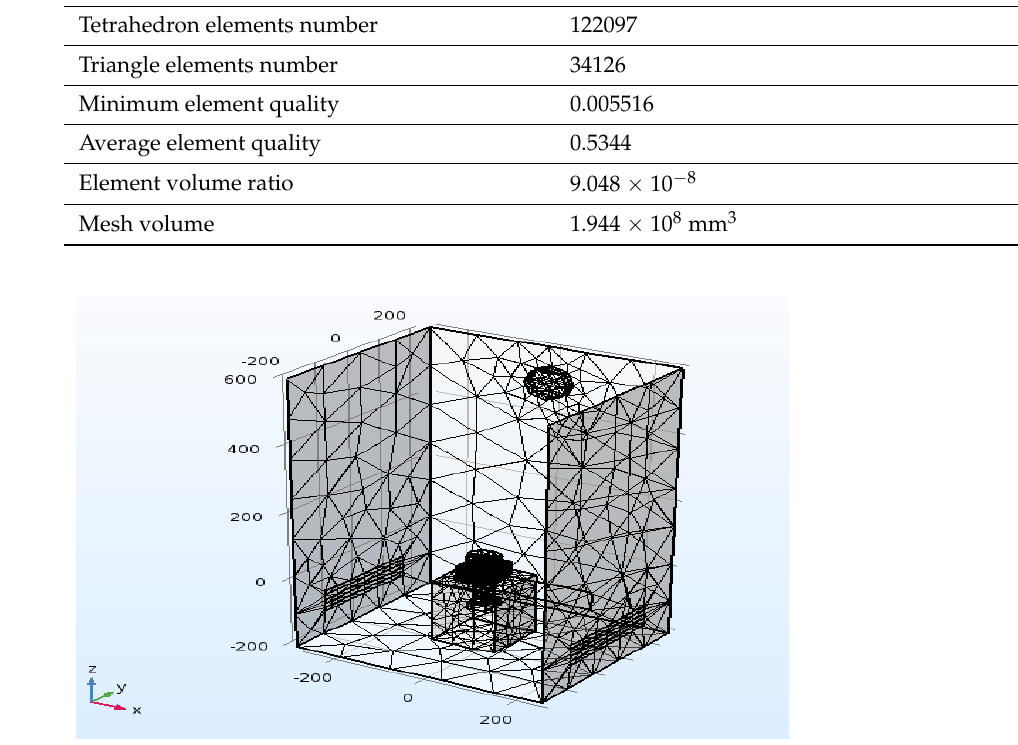
Table 2. Mesh construction parameters.